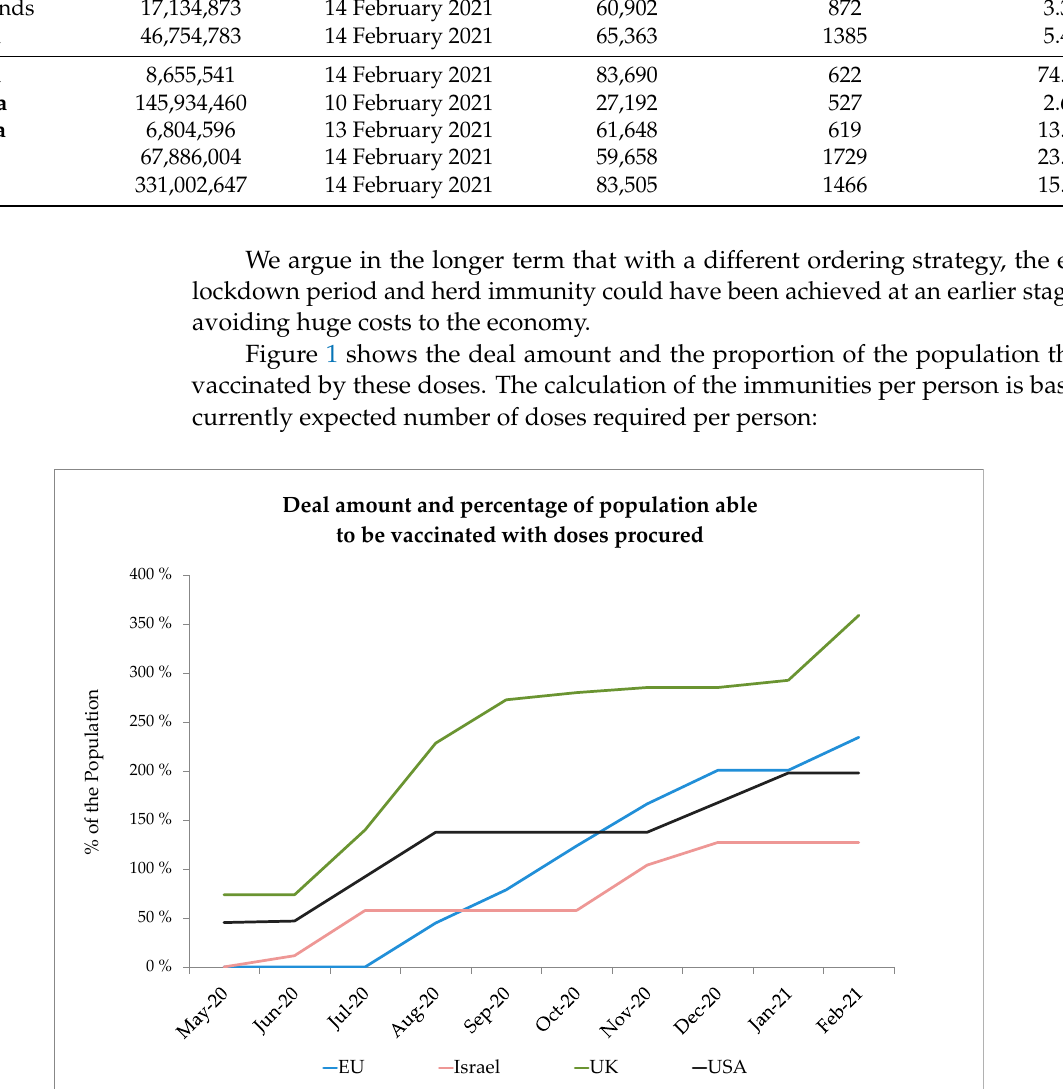
Table 1. Vaccinations per 14 February 2021 (Source [3]).